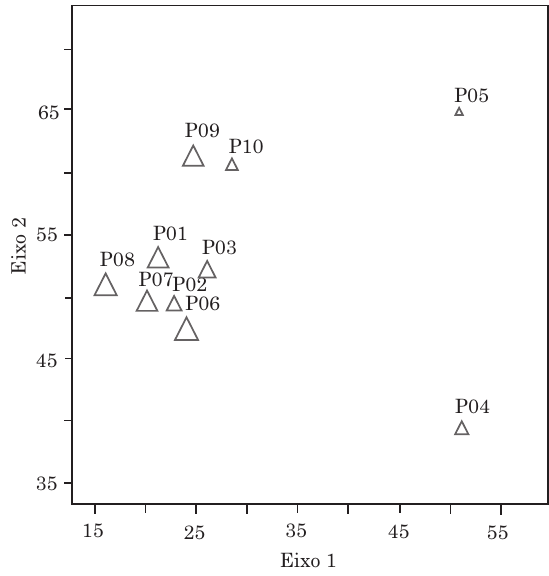
Figure 2. Inter-relationship between the distribution of study environments and species Lychnophora pohlii Sch. Bip with highest abundance values in the total sample. P01 - P10 represent the 10 sampled plots and the size of the triangles is proportional to the number of plants.